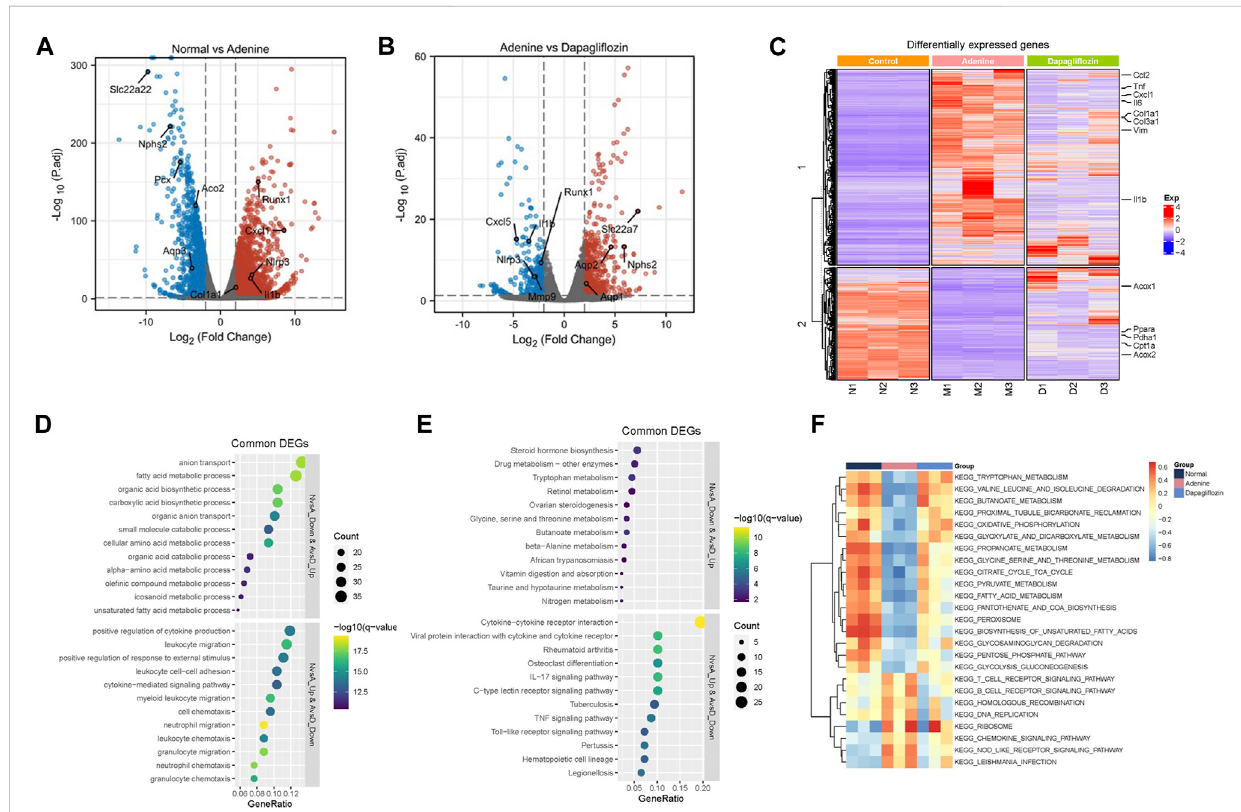
FIGURE 3 Analysisofrenaltranscriptomein0.2%adeninediet-inducedrenal fi brosismice. (A) Volcanoplotofgeneexpressiondifferencebetweenthecontrol and 0.2% adenine diet groups. (B) Volcano plot of gene expression difference between the 0.2% adenine diet and 10 mg/kg dapagli fl ozin treatment groups. (C) Heatmap of gene expression difference among the control, 0.2% adenine diet, and dapagli fl ozin 10 mg/kg groups. (D) GO analysis of differentially expressed genes. (E, F) KEGG analysis of differentially expressed genes. N: control diet M: 0.2% adenine diet D 0.2% adenine diet + dapagli fl ozin (10